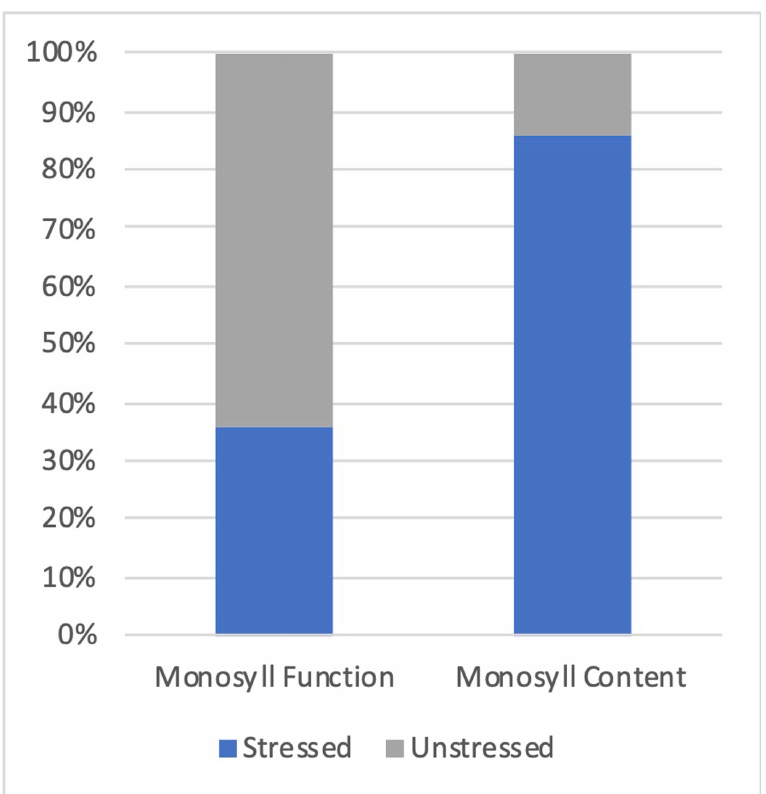
Figure 10: Results (Test data set of experiment 2 n ) for function and content monosyllabic